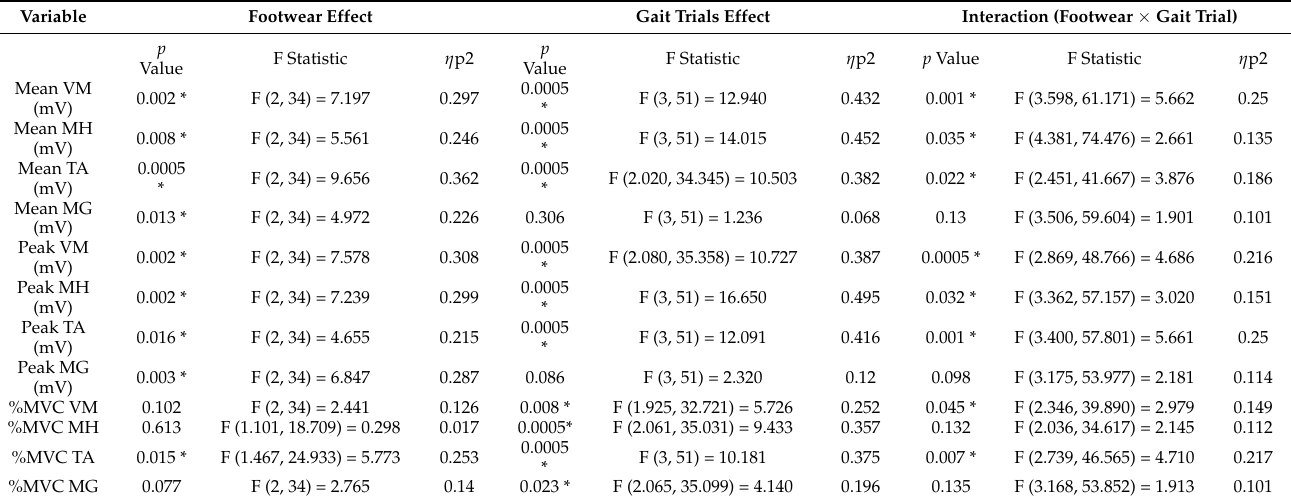
Table 1. Repeated measures analysis of variance (ANOVA) table for footwear and gait main effect and footwear × gait